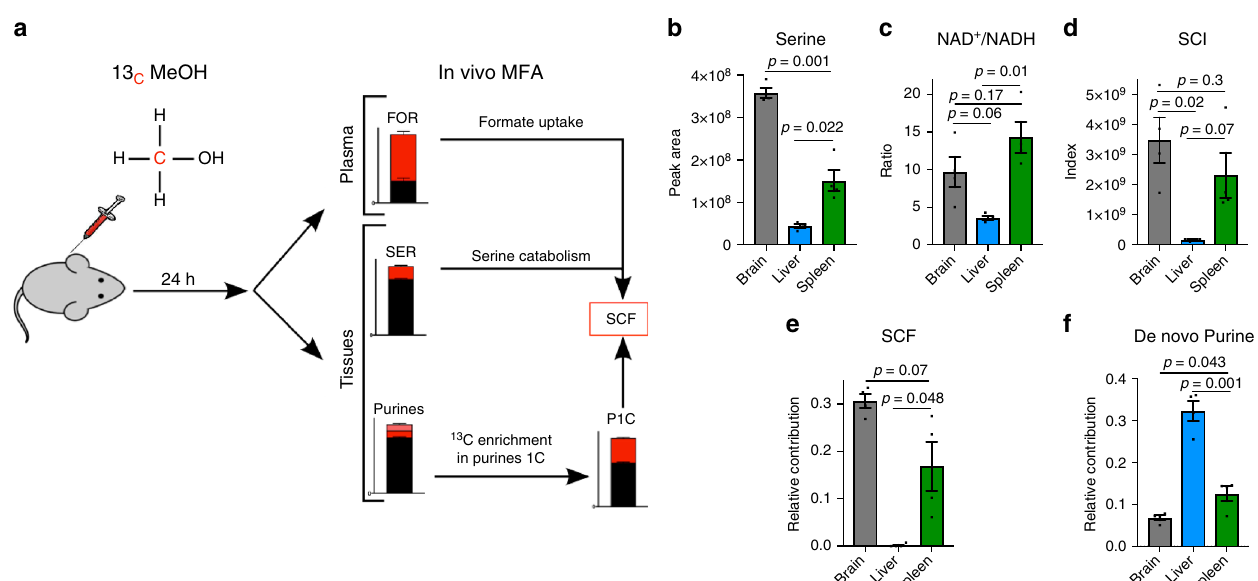
Fig. 3 Baseline rates of serine catabolism to formate in murine tissues. a Diagram illustrating the 13 C-methanol tracing and in vivo metabolic fl ux analysis protocol. b – d Serine, NAD + /NADH and SCI for brain, liver and spleen samples from mice 24 h post 13 C – MeOH injection. e Relative rate of serine catabolism to formate (SCF) of brain, liver and spleen as estimated from the 13 C – MeOH tracing protocol. f De novo purine synthesis rate in brain, liver and spleen inferred from the 13 C enrichment of purines. Results were obtained from three mice ( n = 3). Error bars denote s.e.m.. p -values are calculated using an unpaired t -test with Welch ’ s